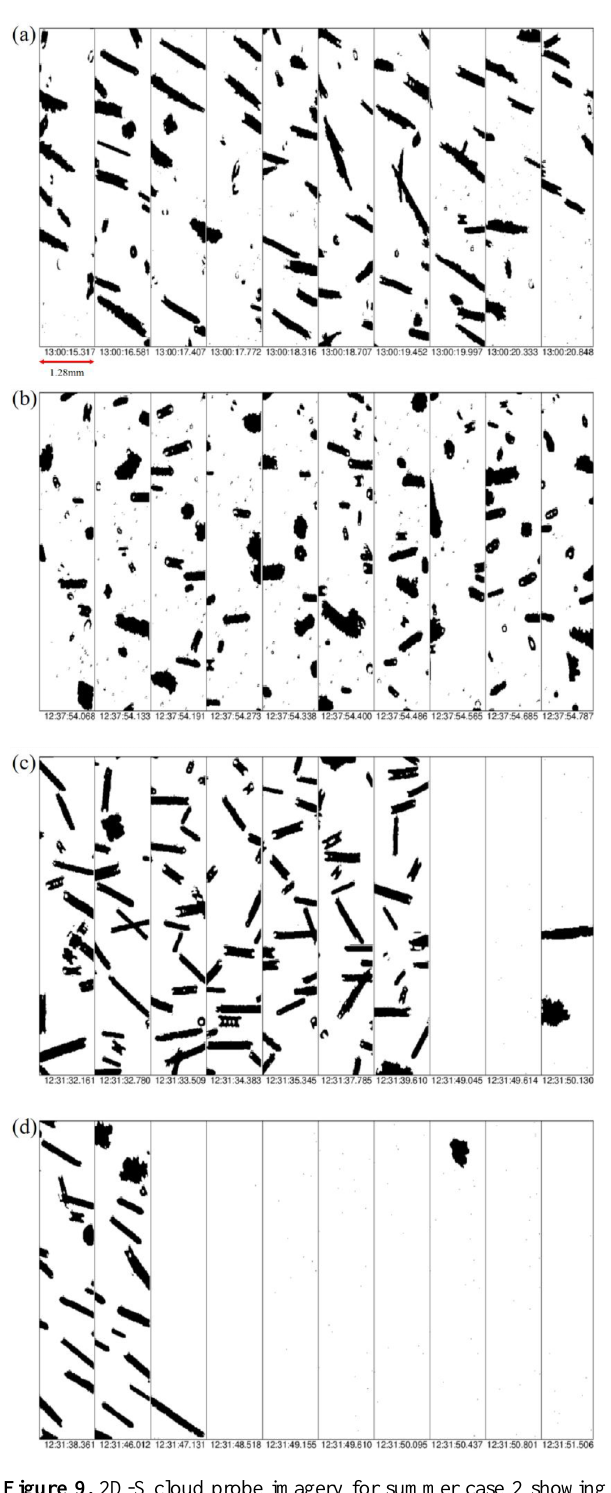
Figure 9. 2D-S cloud probe imagery for summer case 2 showing (a) columnar ice during D1, (b) images of columns together with liquid during D2 and swift transitions between (c) glaciated and (d) liquid phases during D2.